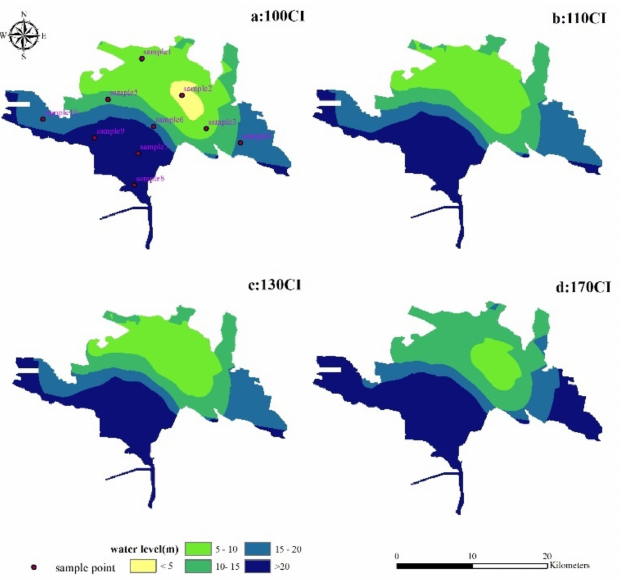
Figure 9. ( a – d ) Spatial distribution maps of groundwater level in 2017 under different cropping intensity scenarios, ( a ) Current cropping intensity (100%), ( b ) 110% cropping intensity, ( c ) 130% cropping intensity, ( d ) 170% cropping